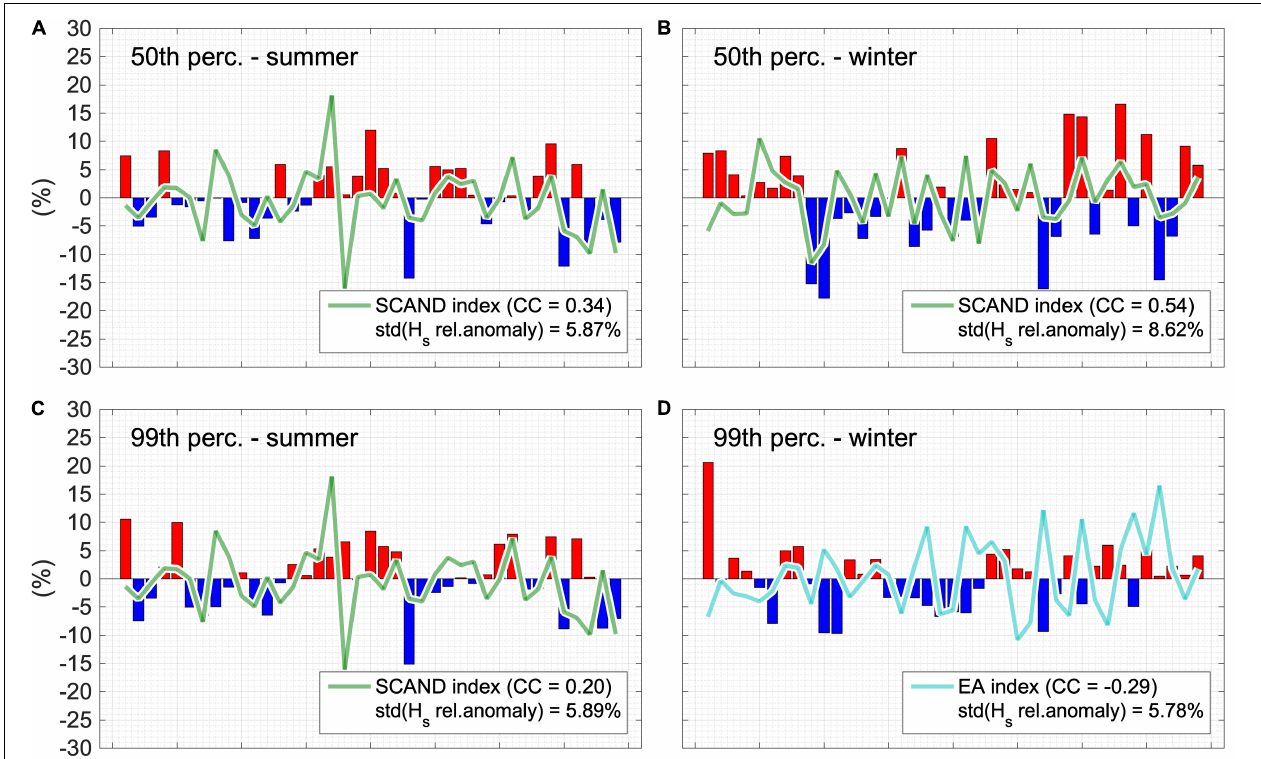
FIGURE 8 | Inter-annual variability of typical and extreme wind-wave climate in the MS (1981–2019). Relative anomaly of 50th [panels (A,B) ] and 99th [panels (C,D) ] percentiles of H s during winter and summer seasons, spatially averaged over the MS. Solid lines represent the most correlated teleconnection indices among NAO, EA, EAWR, and SCAND (correlation coefficient CC in the legend; indices are magnified ten times for graphical